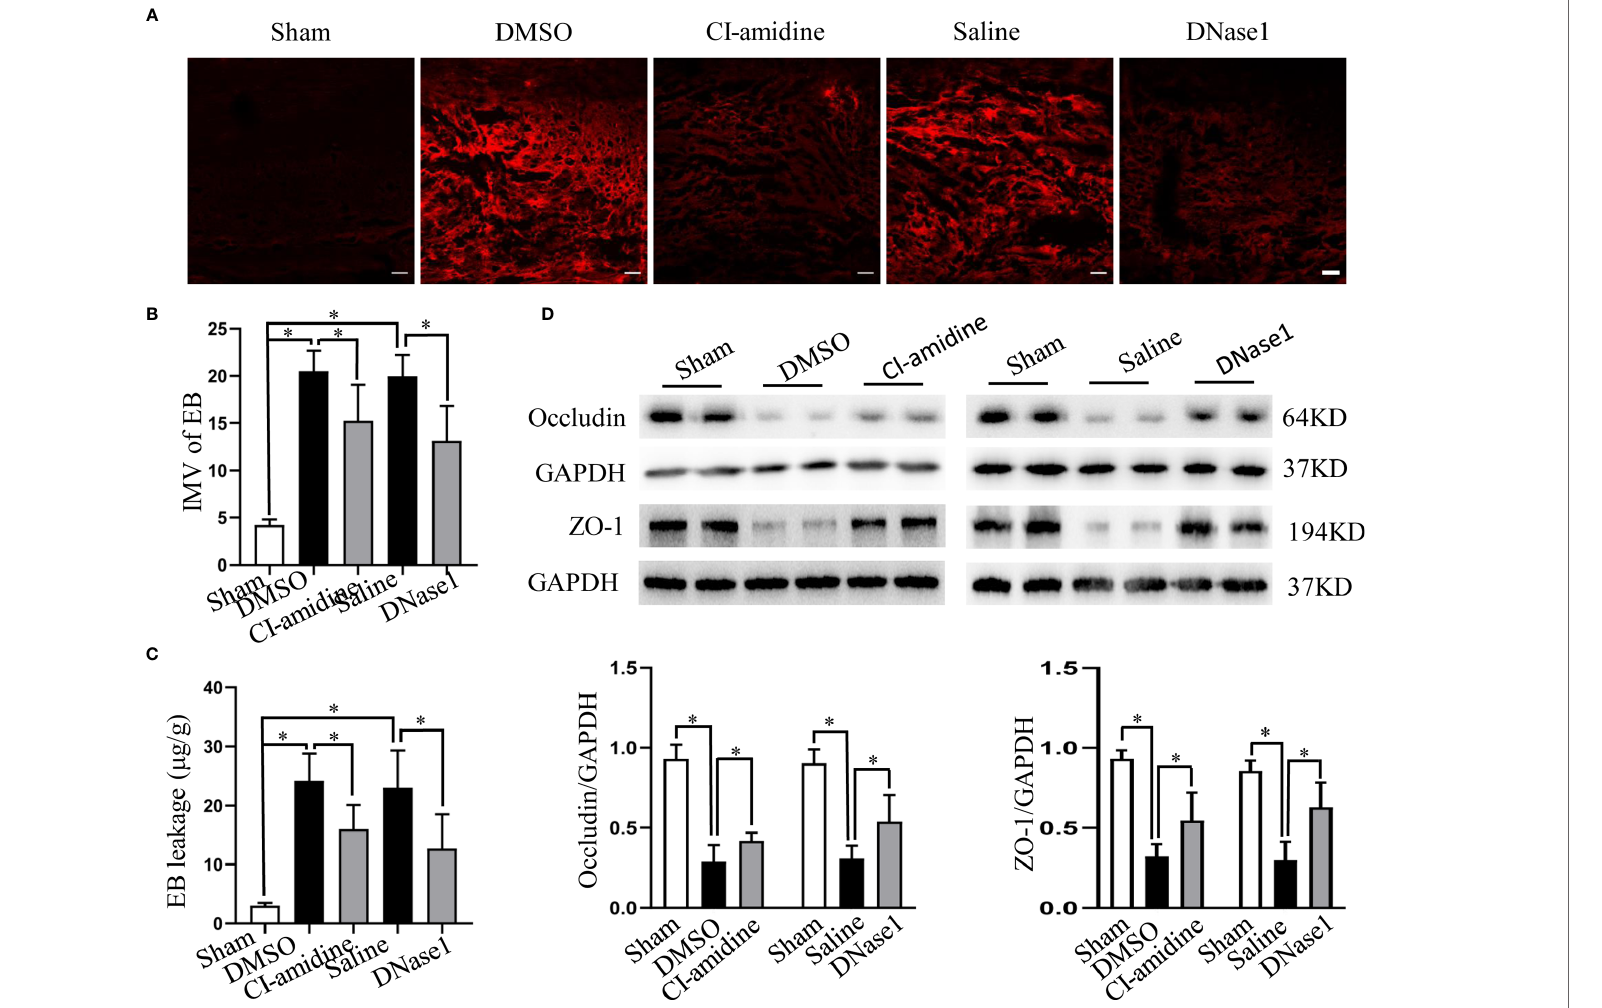
FIGURE 8 | NETs promote BSCB disruption after SCI. (A) Representative fl uorescence images of EB (red) leakage at the injury epicenter of each group at 24 h after operation. Scale bars = 100 m m. (B) Fluorescence intensity mean value (IMV) of EB at the injury epicenter of each group. (C) Quanti fi cation of EB leakage at the injury epicenter of each group at 24 h after operation. (D) Representative immunoblots and quanti fi cation of the BSCB tight junction proteins (ZO-1, occludin) levels in injured spinal cord of each group at 24 h after operation. Data are presented as means ± SD of n = 6 (* p <